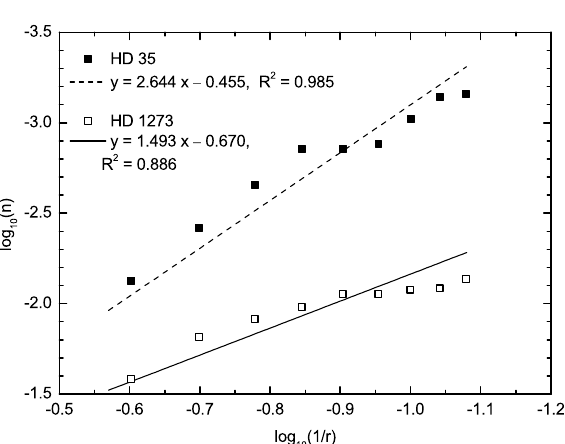
Fig. 4. Log-log plot of the dependence of conditional density on radius in the neigh- borhood of stars HD 1273 and HD